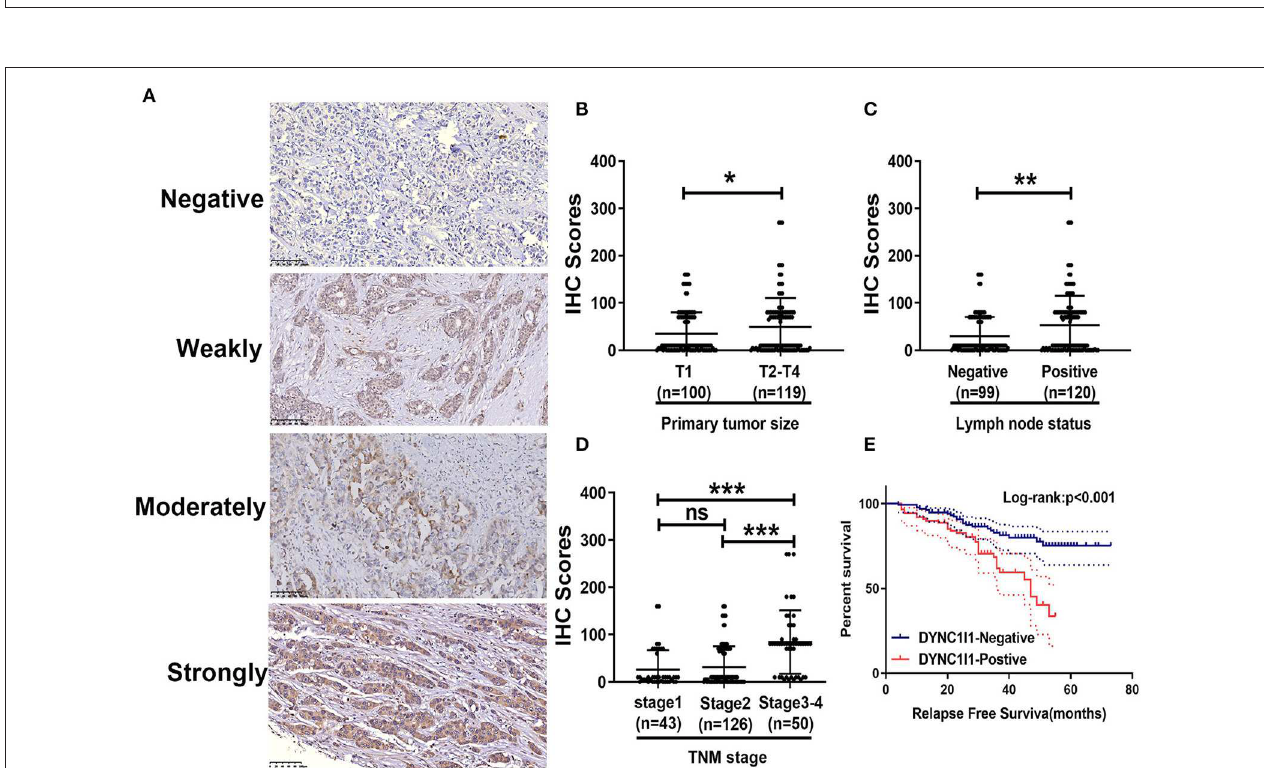
FIGURE 4 | The expression of DYNC1I1 correlates with clinical characteristics and poor prognosis in breast cancer patients. (A) Representative images of DYNC1I1 staining in human breast cancer tissue samples: “–” (negative staining), “ + ” (weak staining), “ ++ ” (moderate staining), and “ + + + ” (strong staining); (B) The IHC score of DYNC1I1 did not differ significantly between different tumor sizes; (C) DYNC1I1 IHC scores of samples related to positive lymph node status were significantly increased; (D) DYNC1I1 IHC staining scores were significantly increased with advanced TNM stage; (E) Kaplan-Meier survival analysis and log-rank test indicated that positive DYNC1I1 expression was associated with poor overall survival ( p < 0.001); * p < 0.05, ** p < 0.01, and *** p < 0.001 (vs. control group).